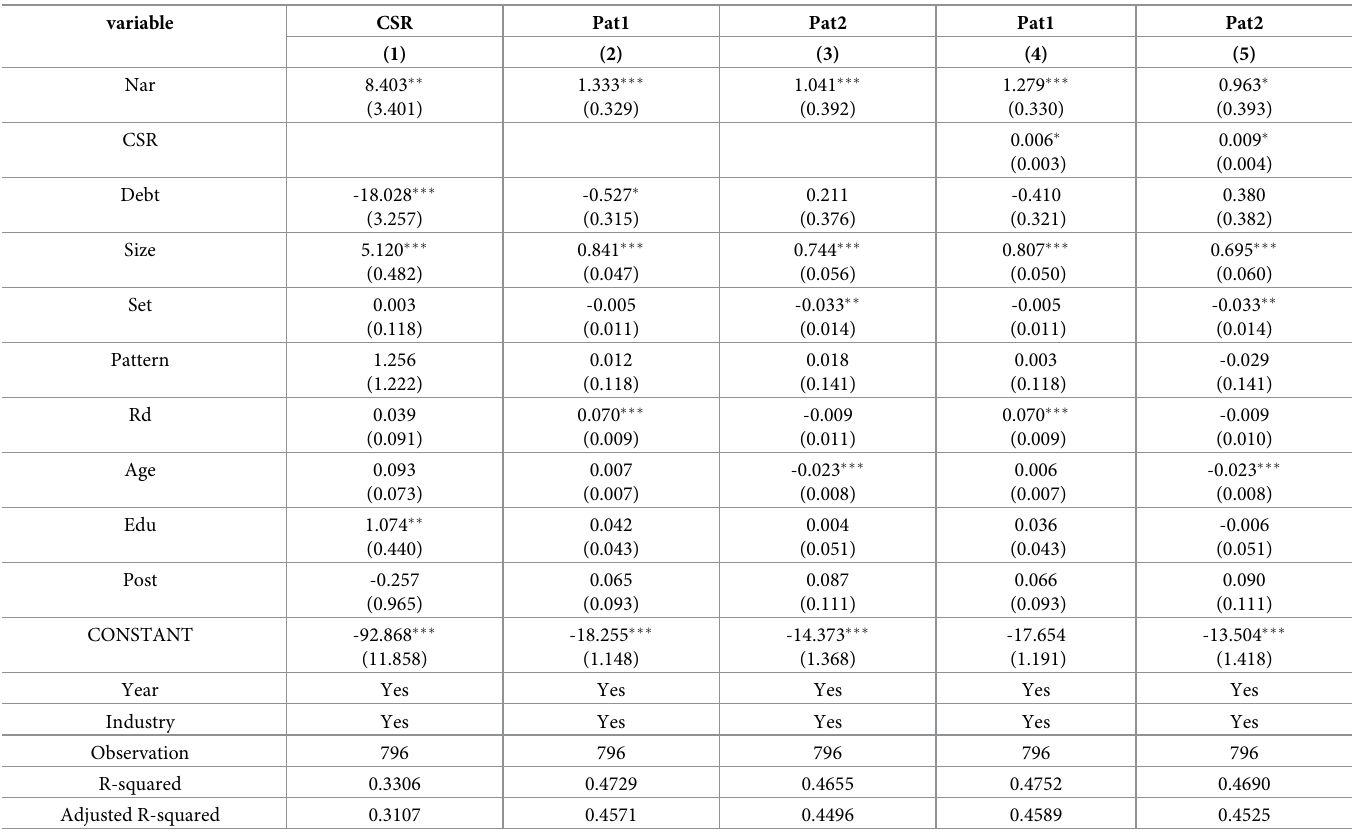
Table 6. The mediating role of